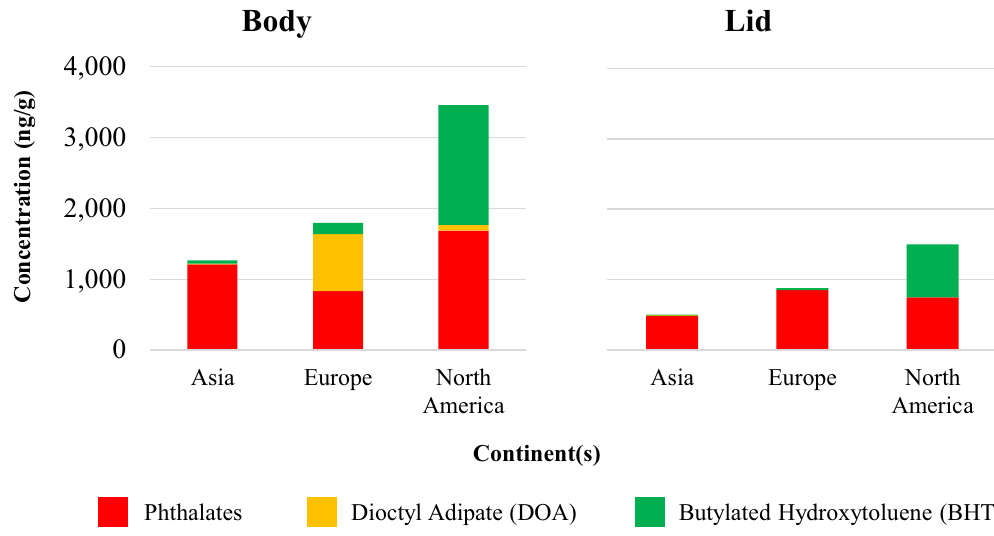
Figure 3. Additive concentrations in coating film of body (left) and lid (right) of beer